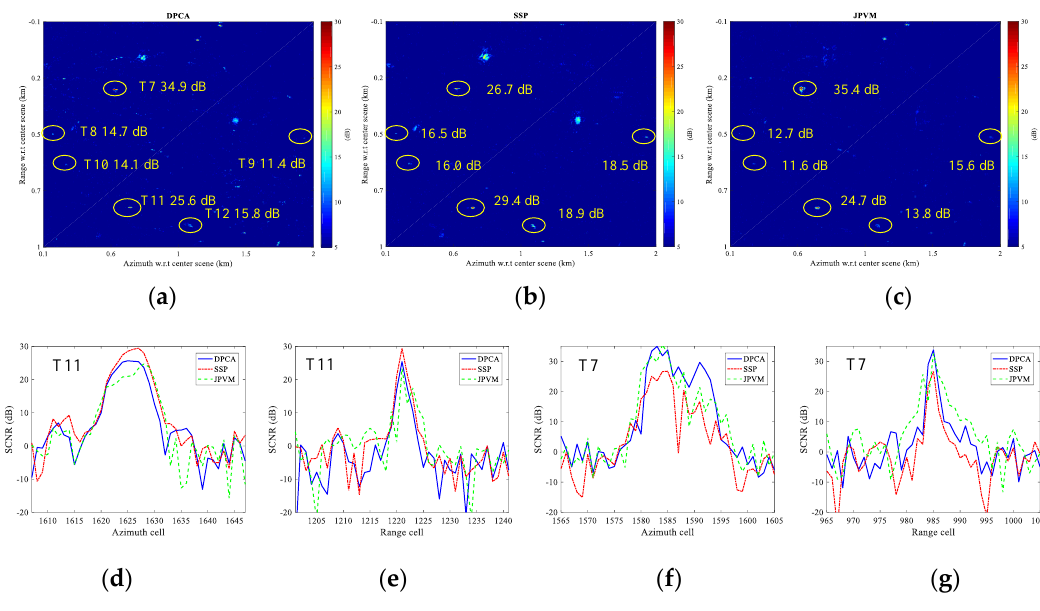
Figure 17. Clutter suppression comparison results with co-registration error of 0.2 pixel (without channel balancing and multilook): ( a ) DPCA; ( b ) SSP; ( c ) JPVM; ( d ) azimuth cut of Target 11; ( e ) range cut of Target 11; ( f ) azimuth cut of Target 7; and ( g ) range cut of Target 7.